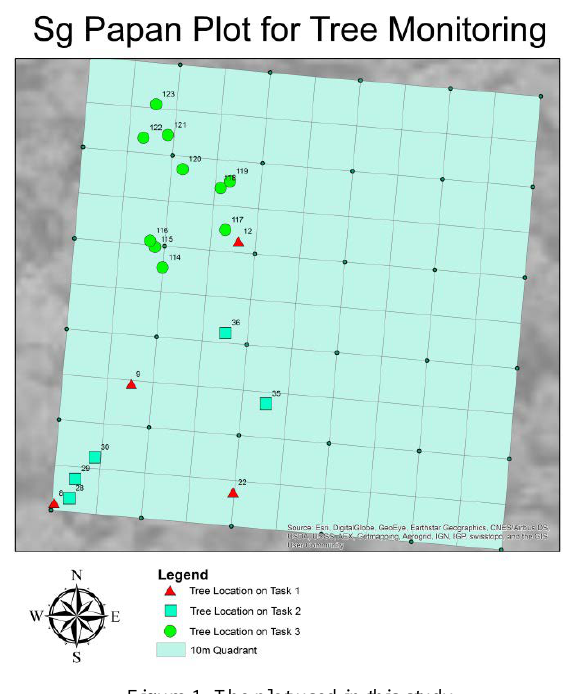
Figure 1. The plot used in this